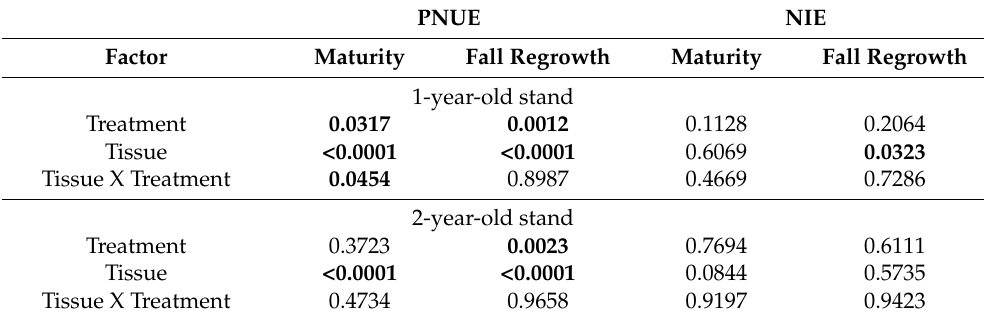
Figure 2. PNUE averaged by treatment in 1-year-old and 2-year-old IWG stands. Within each stand age, bars with the same or no letter are statistically similar, as per Tukey’s HSD ( p = 0.05). Table 4. Results of analysis of variance to test for significant nitrogen-addition treatment and tissue- type effects on Physiological Nitrogen use Efficiency (PNUE) and Nitrogen Input Efficiency